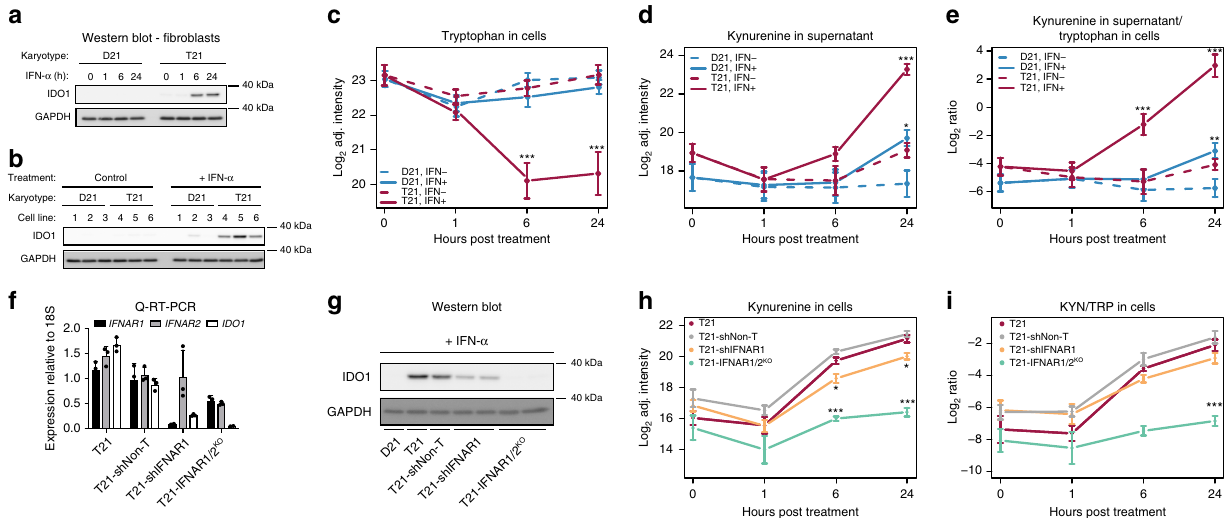
Fig. 3 T21 sensitizes cells to KP induction via IFNR gene dosage. a Western blottings demonstrating the upregulation of IDO1 over a 24 h time course in an age- and gender-matched pair of fi broblasts with (T21) or without (D21) trisomy 21. b Western blot analysis con fi rming IDO1 super-induction in multiple T21 fi broblasts after 24 h of IFN- α treatment. 1 – 3 are cell lines from controls, 4 – 6 are cell lines from individuals with trisomy 21. c Metabolic tracing experiment using isotopolog-labeled ( 13 C 11 15 N 2 ) tryptophan in fi broblast cell lines ( n = 6, 3 with T21). Levels of isotopolog-labeled tryptophan in D21 and T21 cell lysates, with or without IFN- α treatment. d Levels of isotopolog-labeled kynurenine in D21 and T21 supernatant, with or without IFN- α treatment. e Ratio of isotopolog-labeled kynurenine in supernatant to isotopolog-labeled tryptophan levels in cells in D21 and T21 supernatant, with or without IFN- α treatment. At each timepoint, the p -value between the untreated (IFN-) and IFN-treated (IFN + ) samples was calculated using a two-tailed Student ’ s t -test. f Q-RT-PCR showing relative mRNA levels of IFNAR1 , IFNAR2 , and IDO1 , in the indicated cell lines. T21-shNon-T indicates cell line expressing a non- targeting shRNA. T21-shIFNAR1 indicates cell line expressing a shRNA targeting IFNAR1. T21-IFNAR1/2 KO indicates a cell population transduced with guide RNAs targeting the fi rst exons of IFNAR1 and IFNAR2 . mRNA expression is expressed relative to 18S ribosomal RNA. g Western blotting showing effects of modulating IFNAR expression as in f on induction of IDO1 protein after 6 h of IFN- α stimulation. h Levels of isotopolog-labeled kynurenine in the indicated cell lines during a 24 h time course of IFN- α treatment. i Ratio of isotopolog-labeled kynurenine to isotopolog-labeled tryptophan levels in the indicated cell lines during a 24 h time course of IFN- α treatment. At each timepoint, the p -value between the parental T21 cell line and each T21 cell line with modi fi ed IFNAR expression was calculated using a two-tailed Student ’ s t -test. Data shown in all panels are mean ± SEM, * p < 0.05, ** p < 0.01, *** p < 0.001.